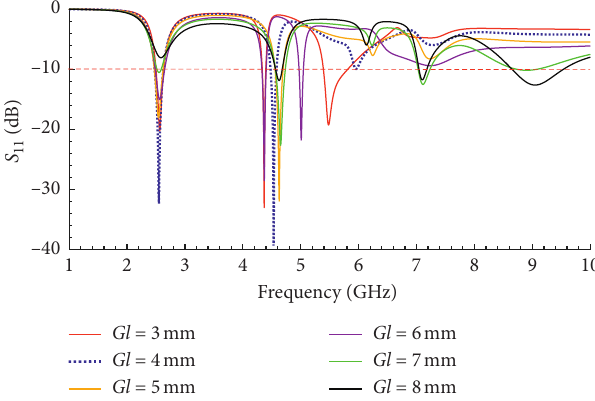
Figure 20: S 11 changes due to BioAs-MPA.